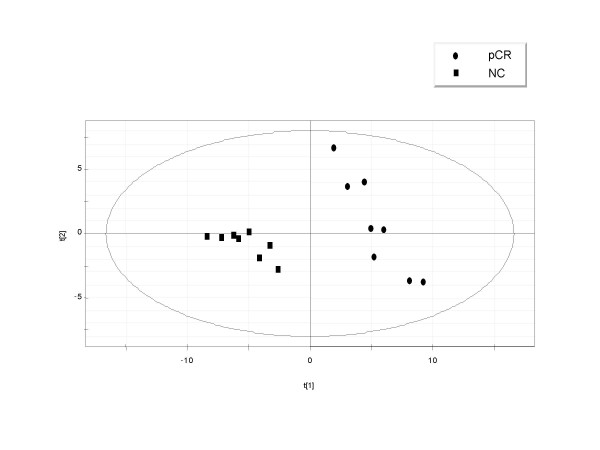
PLS discrimination according to tumor response class using the variables selected by PLS (VIP > 1.9) and ratio (pCR/NC) > 1.9 or < 0.55. Model 1 (PR cases were deleted; class 1 – pCR, black dots; class 2 – NC, black squares); 96 probe sets (cDNAs) retained.